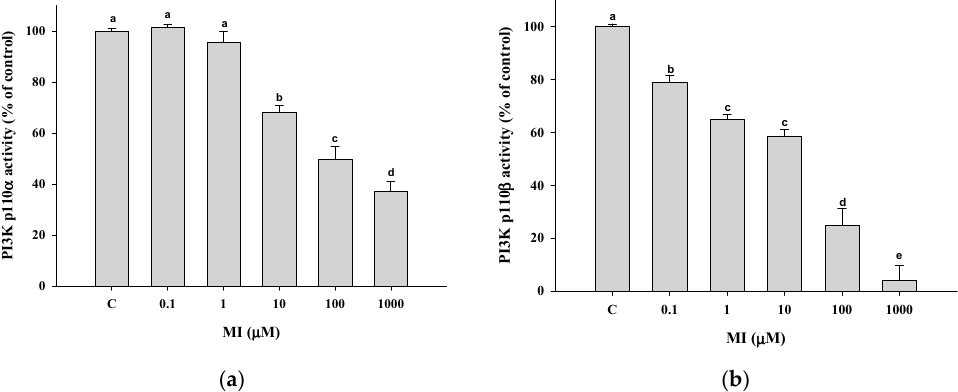
Figure 7. Effects of the myo-inositol (MI) on the phosphoinositide 3-kinase (PI3K) activity. Two isoforms of the PI3K enzyme, ( a ) p110 α and ( b ) p110 β , were incubated with different concentrations of MI. The PI3K activity was detected by a commercial PI3K kit as described in Methods. The inhi- bition percentage of MI on the PI3K isozymes is expressed as the mean ± SD (n = 3 independent experiments); Values not sharing a common letter are significantly different ( p < 0.05).